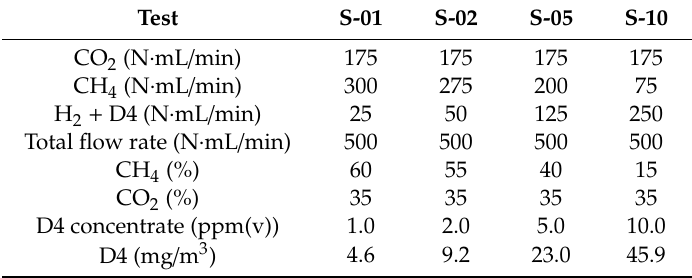
Table 1. Experimental conditions adopted for each sample tested: biochar (BIO), C64, and